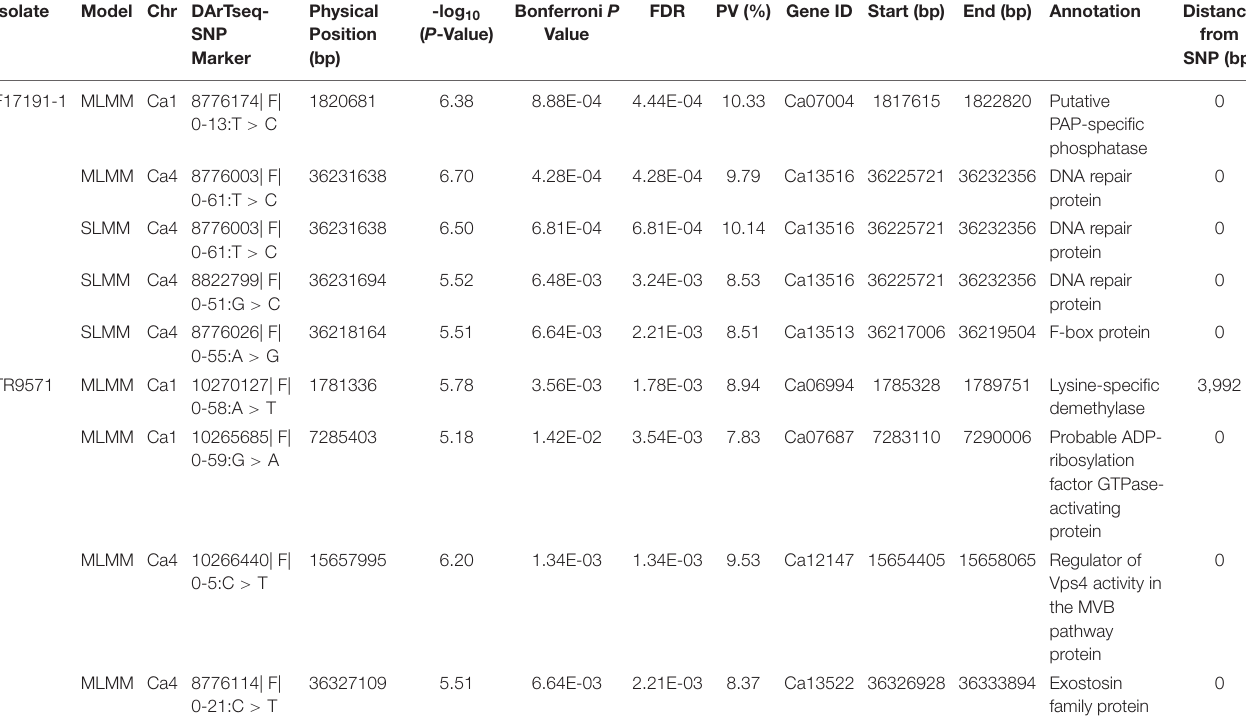
TABLE 2 | Summary of genetic loci associated with Ascochyta blight resistance in GWAS set of Australian chickpea breeding germplasm against two Ascochyta rabiei isolates using DArTseq SNP-based SLMM and MLMM. Isolate Model Chr DArTseq-